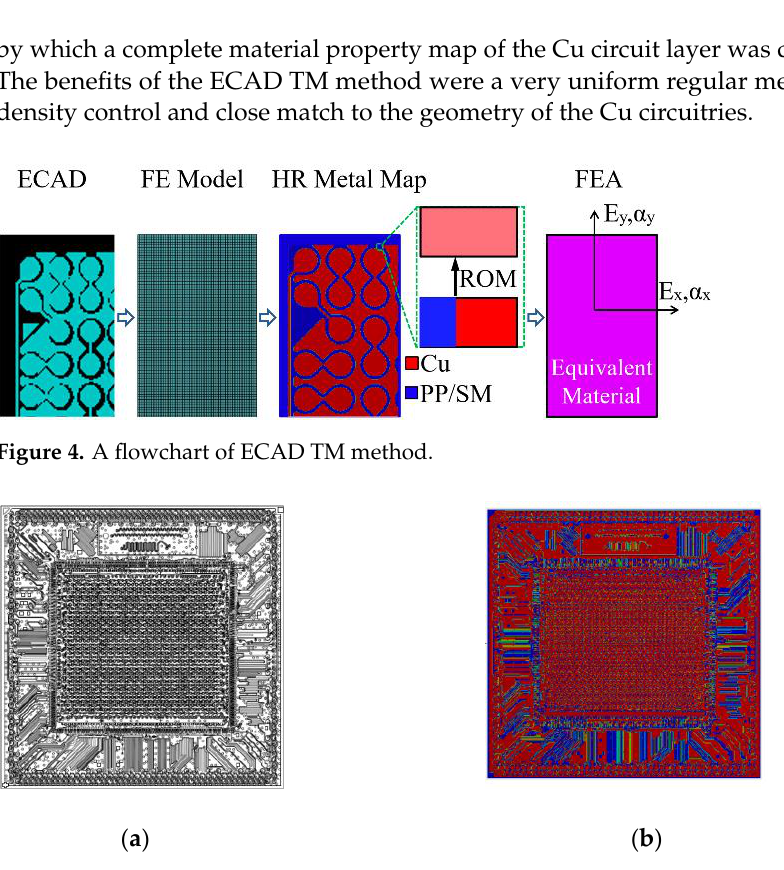
Figure 5. A Cu circuit layer in a substrate: ( a ) Cu circuitry pattern; ( b ) Approximate FE model.